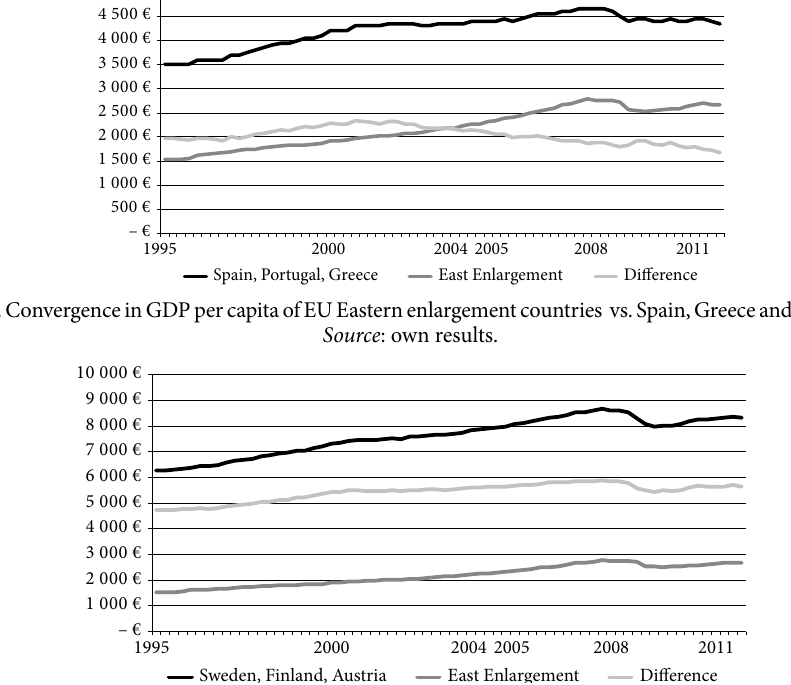
Fig. 7. Convergence in GDP per capita of EU Eastern enlargement vs. Finland, Sweden and Austria Source : own